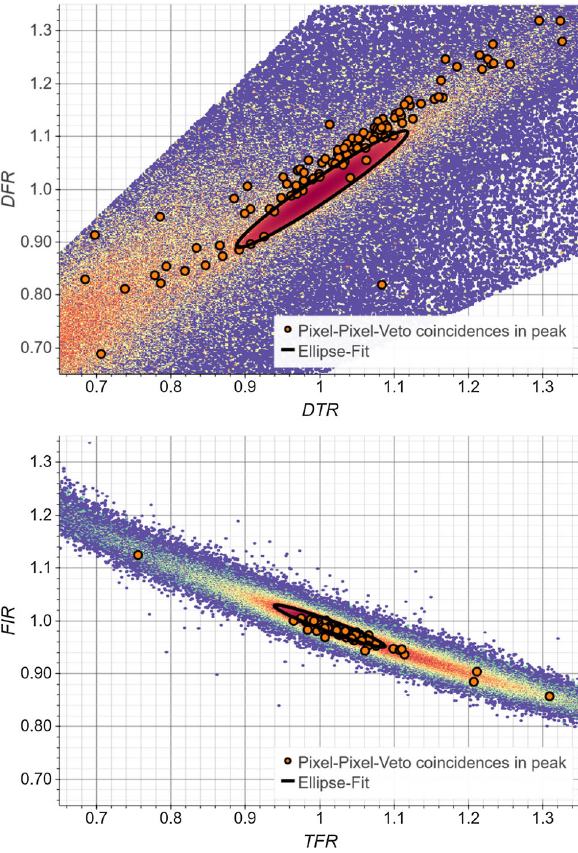
Fig. 17 Sample of non useful parameter spaces. It is clearly visible that these parameters are correlated